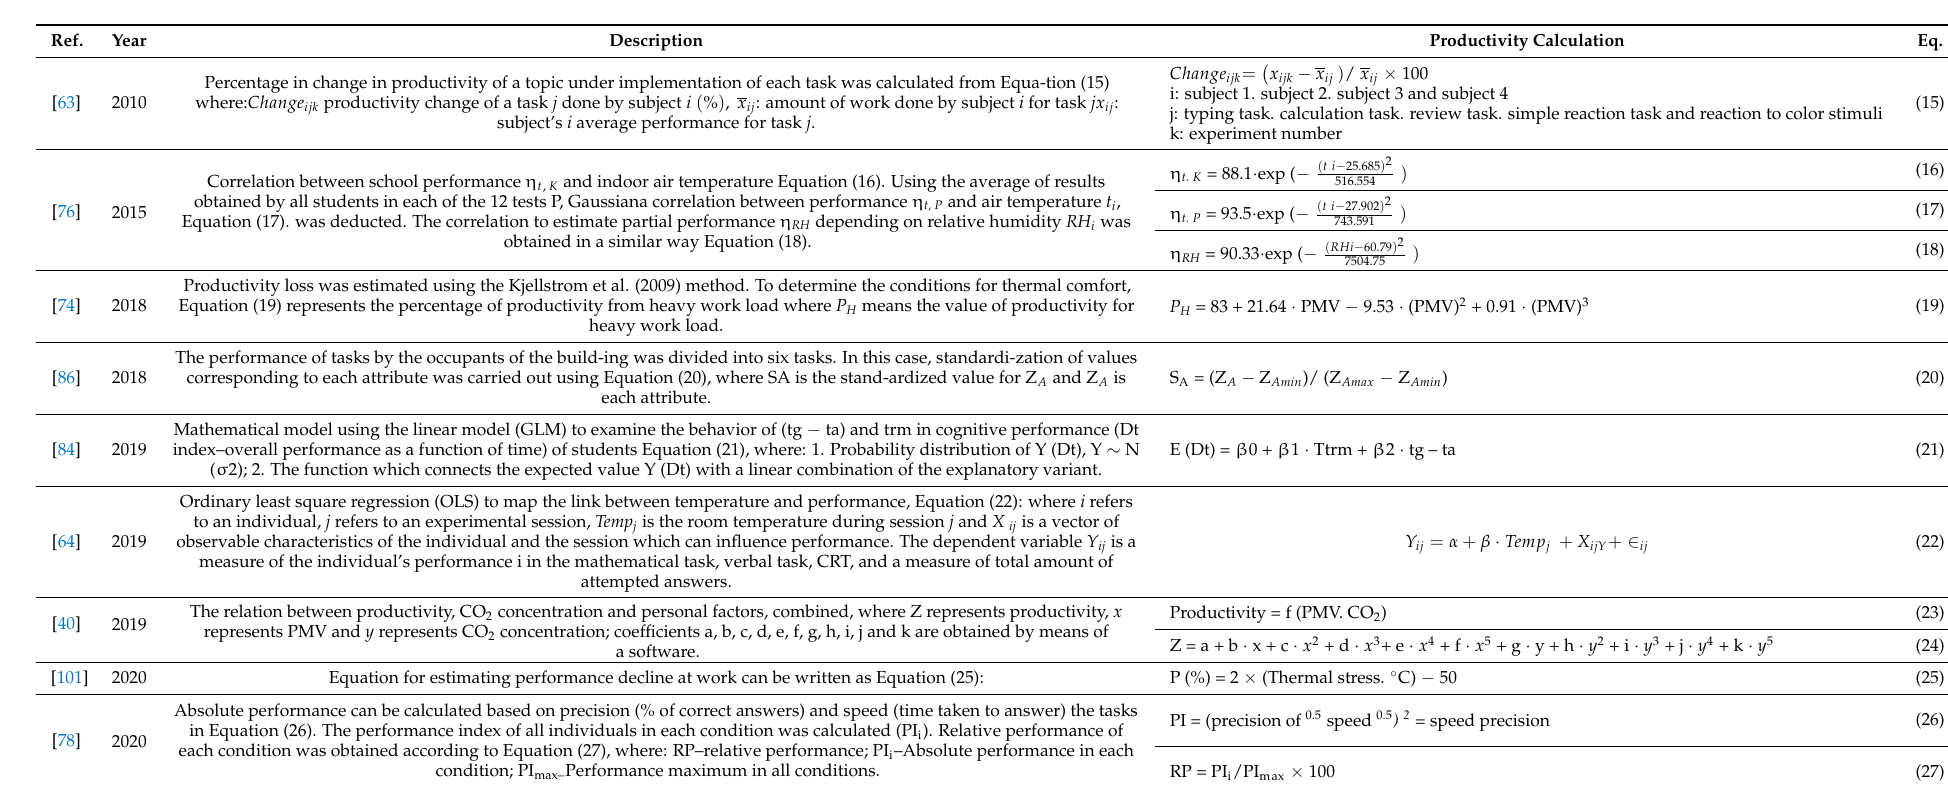
Description Productivity Calculation